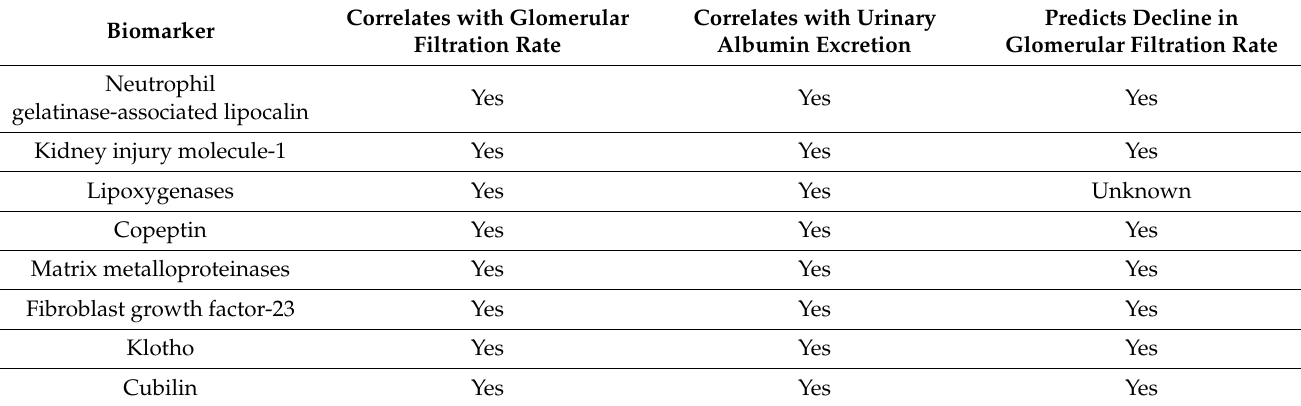
Table 2. Novel biomarkers associated with increased cardiovascular risk in patients with diabetic kidney disease. Predicts Myocardial Predicts Cardiovascular Biomarker Predicts Ischemic Stroke Infarction Mortality Conflicting results Conflicting results Conflicting results Conflicting